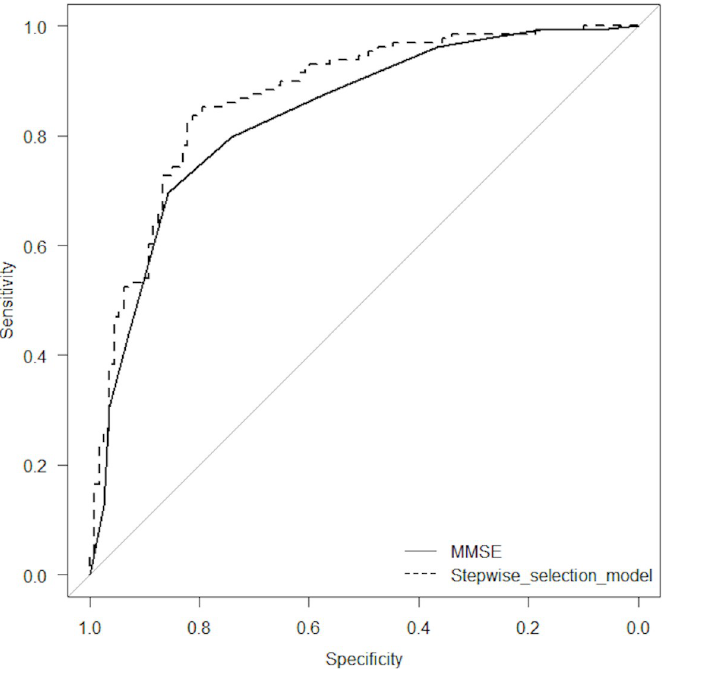
Fig 1. Receiver operating characteristic (ROC) curve